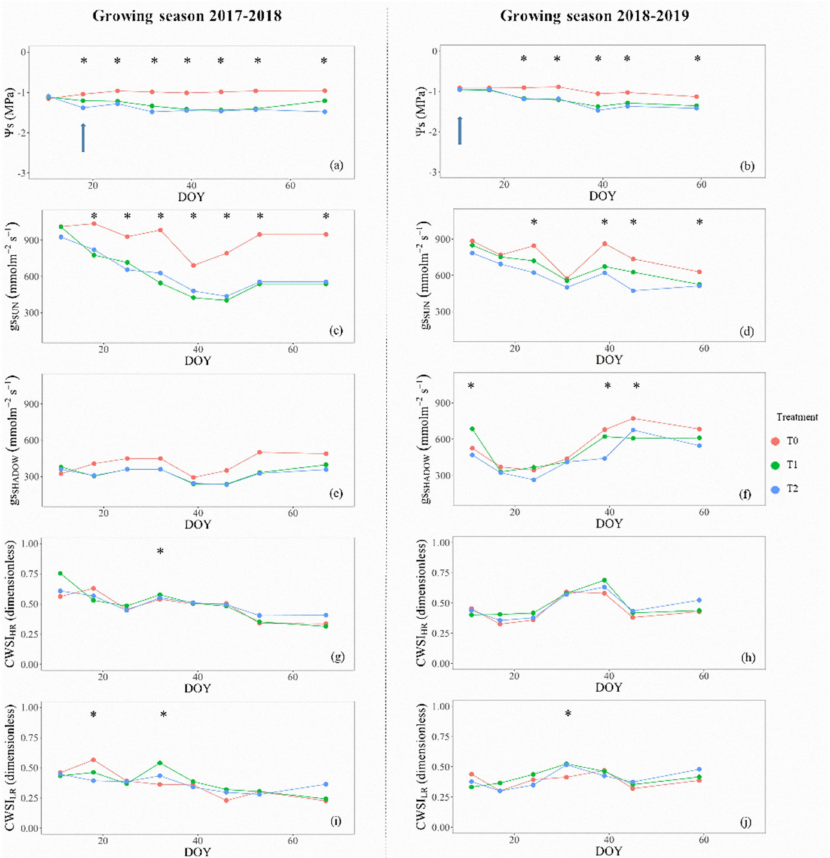
Figure 6. Seasonal evolution of averaged values of midday stem water potential, stomatal conductance, and crop water stress index of cherry trees ‘Sweetheart’, for each post-harvest irrigation treatment (control: T0 ( Ψ s ≥ − 1.0 MPa); low–medium water stress: T1 ( − 1.0 ≥ Ψ s ≥ − 1.5 MPa), and high